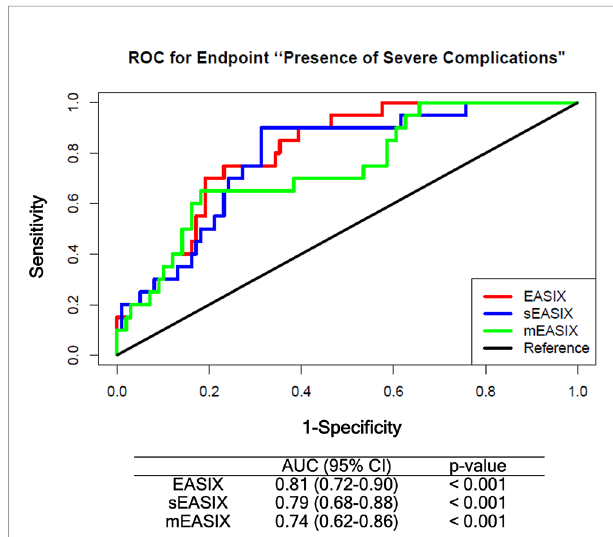
TABLE 3 | Multivariable logistic regression (Firth correction) with the EASIX cutoff (categorial) (Validation cohort, n = 121, 21 events). Binary Endpoint: CRS/ICANS ≥ 3 OR (95% CI) p -value EASIX-pre (cutoff >4.67) EASIX, Endothelial Activation and Stress Index; pre, prior lymphodepletion; log, logarithm; CRS, cytokine release syndrome; ICANS, immune effector cell-associated neurotoxicity syndrome; OR, odds ratio; 95% CI, 95 percent con fi dence interval. Diagnosis patients with aggressive B-cell lymphoma vs. other. Disease status: patients with progressive or refractory disease vs. patients with stable disease or response (complete or